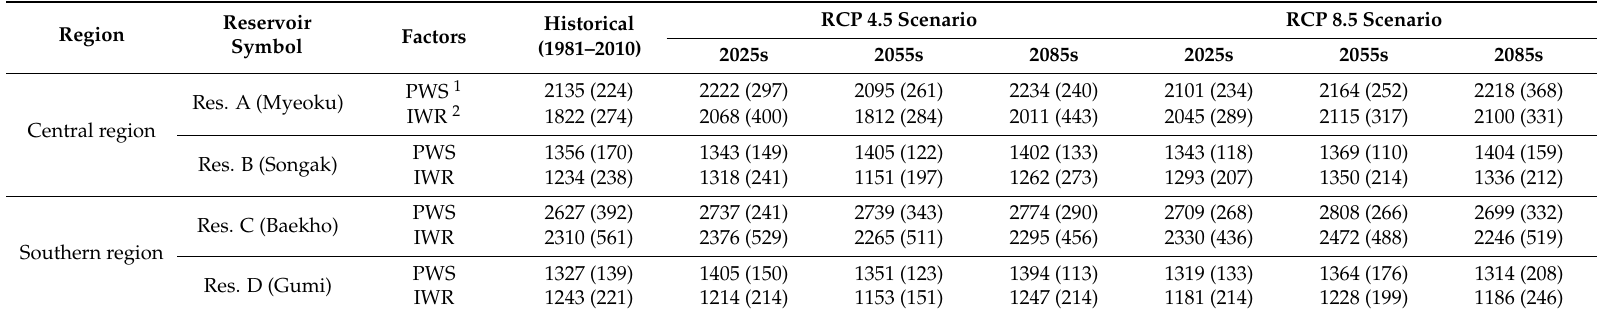
Table 7. Comparisons of PWS and IWR between the historical period and climate change